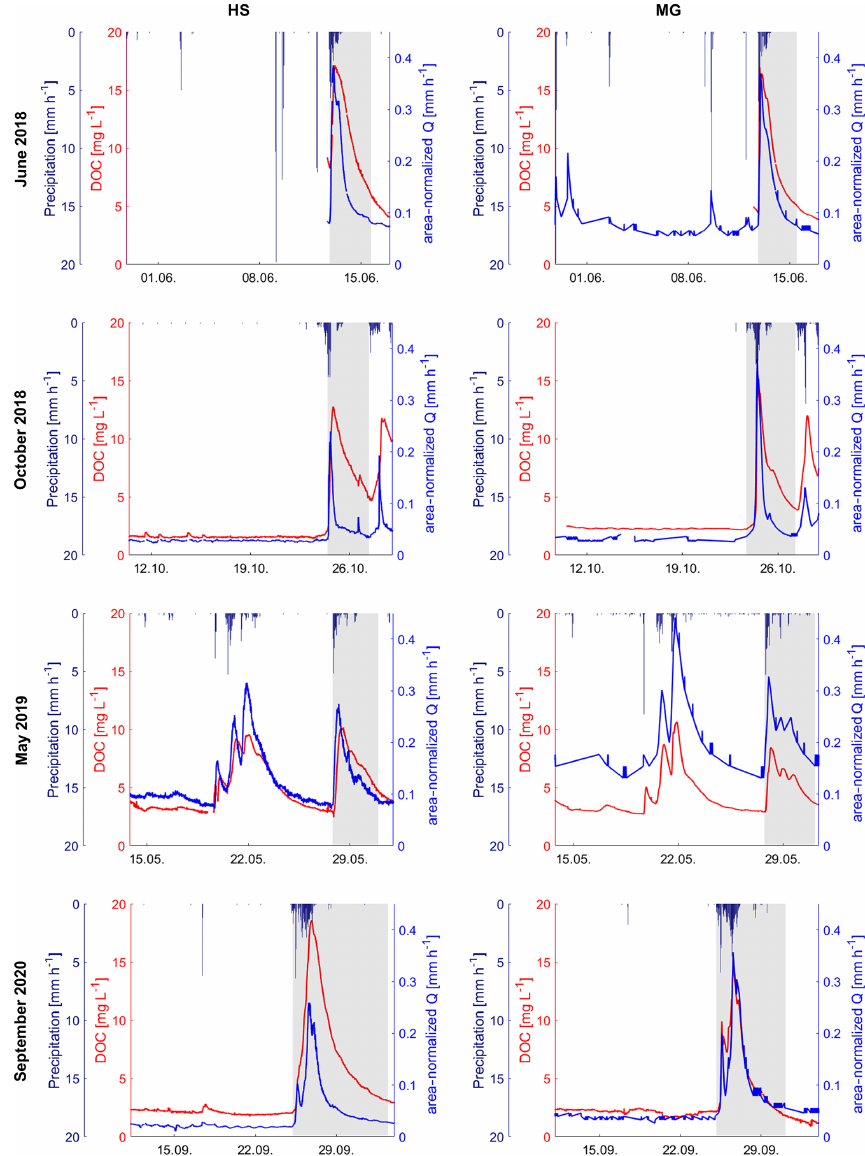
Figure 4. DOC concentrations and area-normalized Q starting 14d prior to the events in June 2018 (top row), October 2018 (second row), May 2019 (third row) and September 2020 (bottom row) at HS (left) and MG (right). The shaded areas highlight the events described in detail in Table